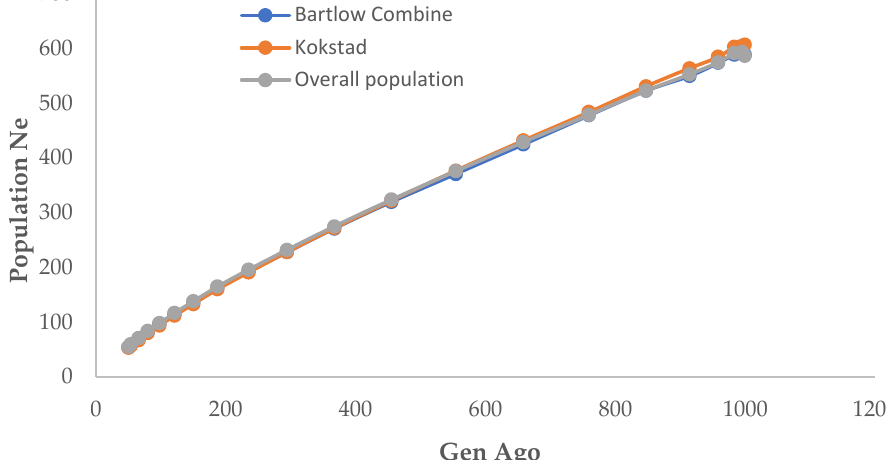
Figure 7. Estimated N e for Bartlow Combine and Kokstad population over time based on linkage disequilibrium data.